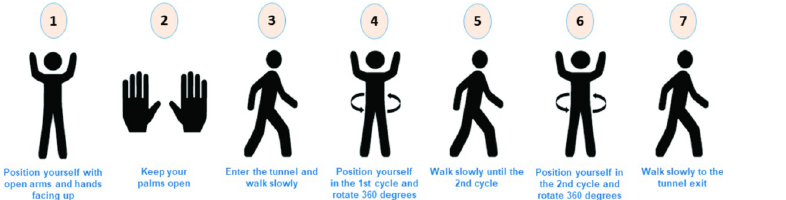
Fig 17. Newly proposed passage procedure for using the disinfection chamber.